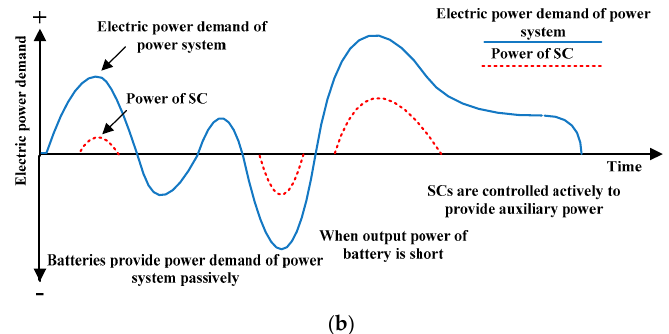
Figure 17. ( a ) Power allocation of SC/battery; and ( b ) power allocation of battery/SC.